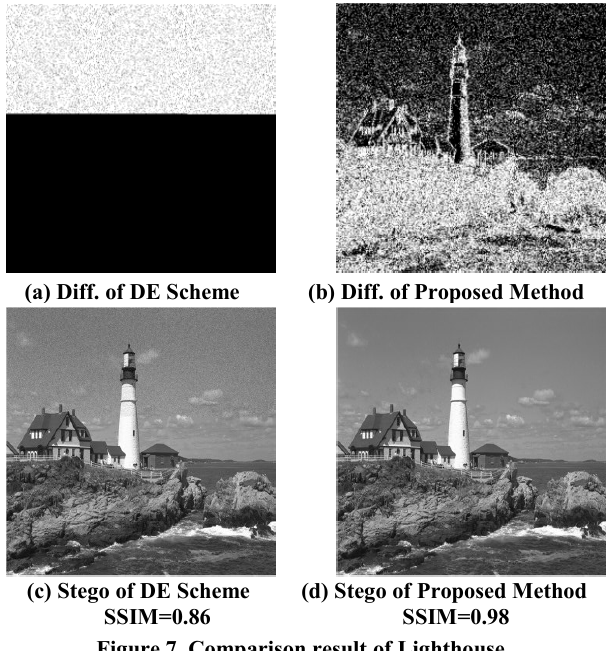
Figure 7. Comparison result of Figure 7 indicates the comparison result of Lighthouse produced by DE method and proposed scheme. (a) and (b) are differences of cover images and stego images. (c) and (d) are stego images. Let Lighthouse. The difference between the cover image and stego image indicates that the DE scheme only embed the upper part of cover image in turn. On the other hand, our proposed method adjustably embeds secret digits into the complex pixel pairs. The difference of stego image between DE scheme and proposed scheme is visually different. Meanwhile, the SSIM of DE scheme is smaller than the SSIM of proposed scheme, which means proposed method improves the visual quality greatly.